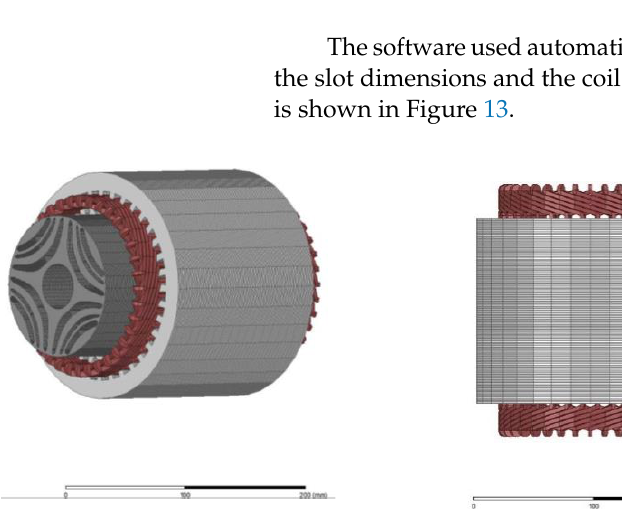
Figure 13. View of the SynRM 3D model from different angles.